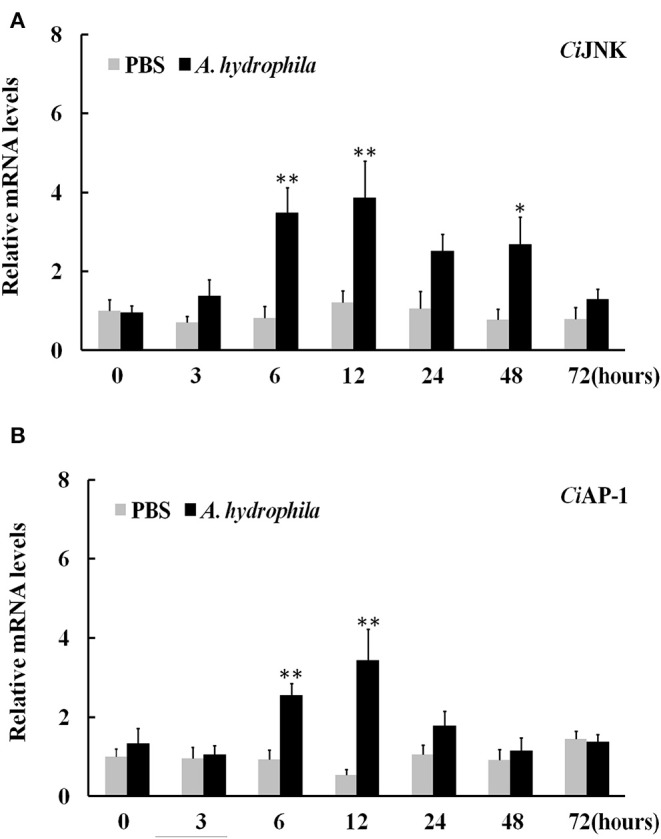
Relative expression of intestinal CiJNK (A) and CiAP-1 (B) in response to Aeromonas hydrophila challenge. The grass carp β-actin gene was used as a reference gene to normalize the expression level. Comparative analysis and statistical tests were performed on the challenge groups and PBS group at the same time point. Each bar represents the mean of the normalized expression levels of replicates (N = 3); significant differences are indicated by an asterisk (* and ** represent P < 0.05 and P < 0.01, respectively).